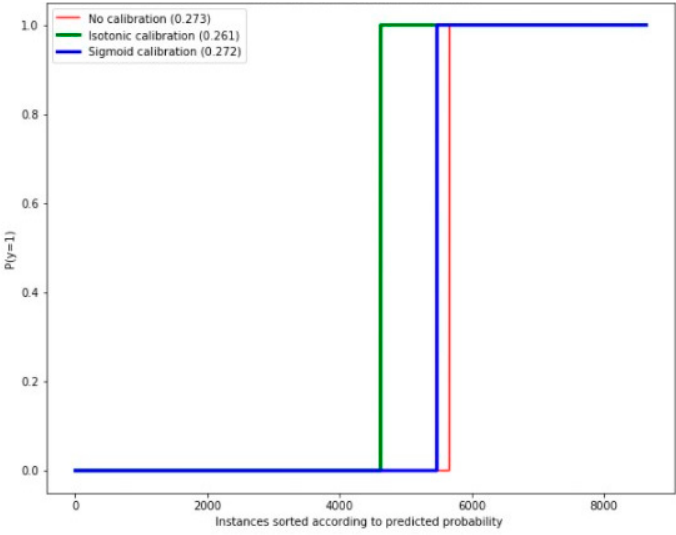
Figure 12. Graphical representation for Brier Score Loss.